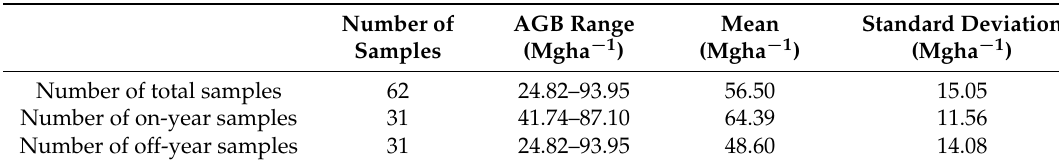
Table 2. Statistics of collected sample plot data.